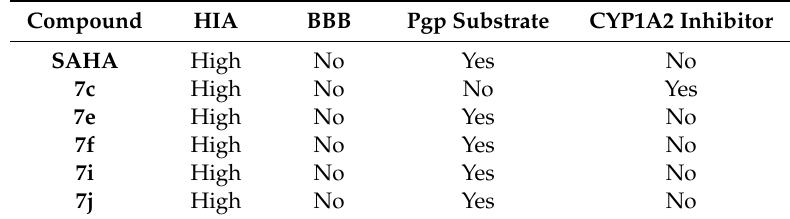
Table 6. Pharmacokinetic parameter of compounds SAHA and 7a – k